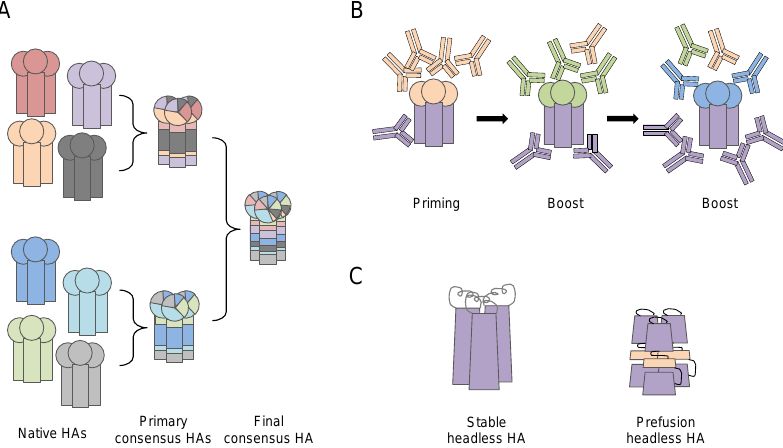
Figure 3. Illustration of antibody targeting next generation influenza vaccine designs. ( A ) Computationally optimized broadly reactive antigens (COBRA) strategy generates primary consensus hemagglutinin (HA) amino acid (aa) sequences from HAs of native circulating influenza strains, and further secondary and final consensus HA aa sequences from the primary consensus HAs based on a computational algorithm and antigenic evolving analysis. The de novo HA proteins with consensus aa sequence can be displayed on virus-like-particles or rescued influenza viruses using reverse genetics. ( B ) Chimeric HA. Conserved HA stalk domain from a circulating virus is combined with an irrelevant HA head domain from viruses that are absent in humans. The priming-boost-boost immunization regimen enhances immunogenicity of the subdominant HA stalk, thus elicits cross-reactive stalk specific antibodies. ( C ) Stable and pre-fusion Headless HA. Mini-HA proteins are engineered to have a correct-folded structure of the stable or pre-fusion stage of HA protein stalk domain. The immunogenicity of HA stalk is greatly enhanced by removing the HA head domain entirely.